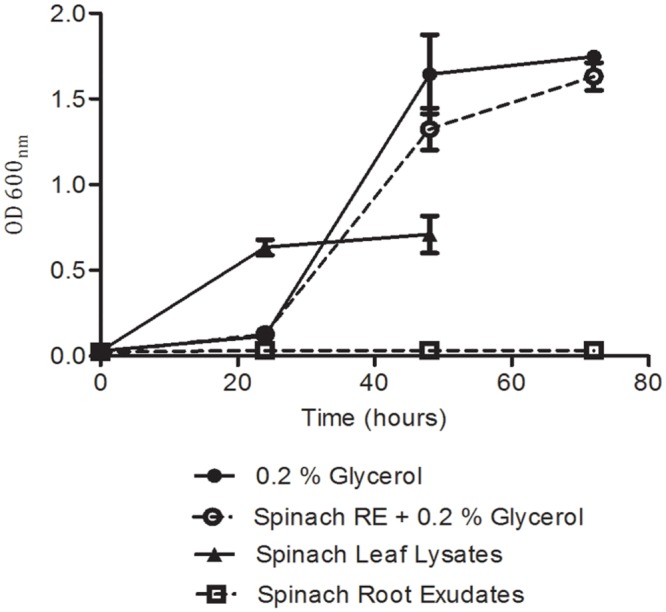
Growth analysis for E. coli O157:H7 (Sakai) in spinach plant extracts. Growth was quantified from cell density of bacteria inoculated into M9 medium supplemented with plant extracts and/or glycerol. Measurements were discontinued for the leaf lysate condition after 48 h, as growth was complete. Data represents the average of nine replicates and was analyzed by one-way ANOVA at selected time points.